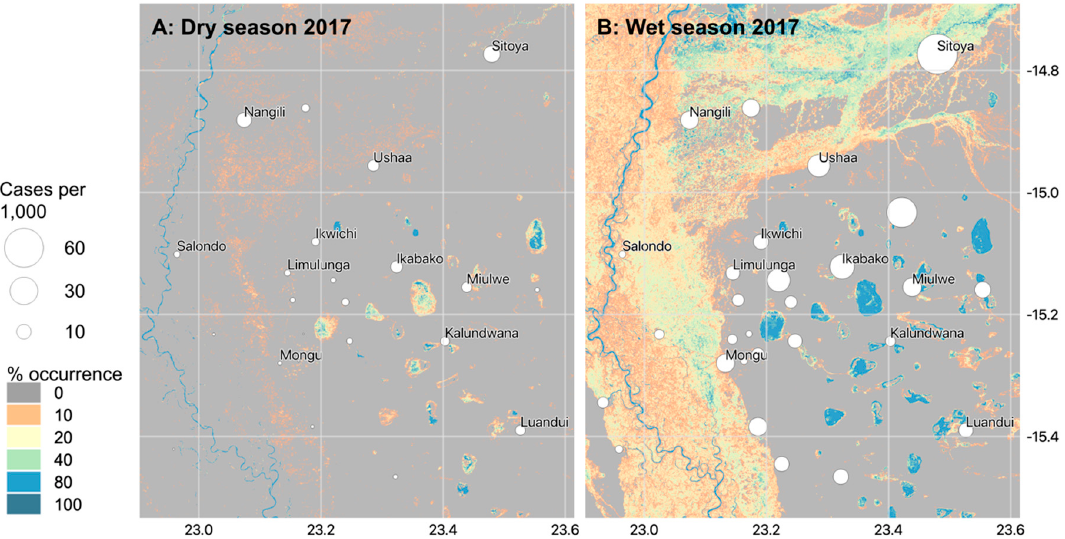
Figure 15. Malaria case data (total number of cases expressed per 1,000 population: https://www.path.org/malaria/) reported by health facilities for the 2017 A) Dry season (Sep-Nov) and B) Wet season (Mar-May), alongside corresponding water occurrence for that period.